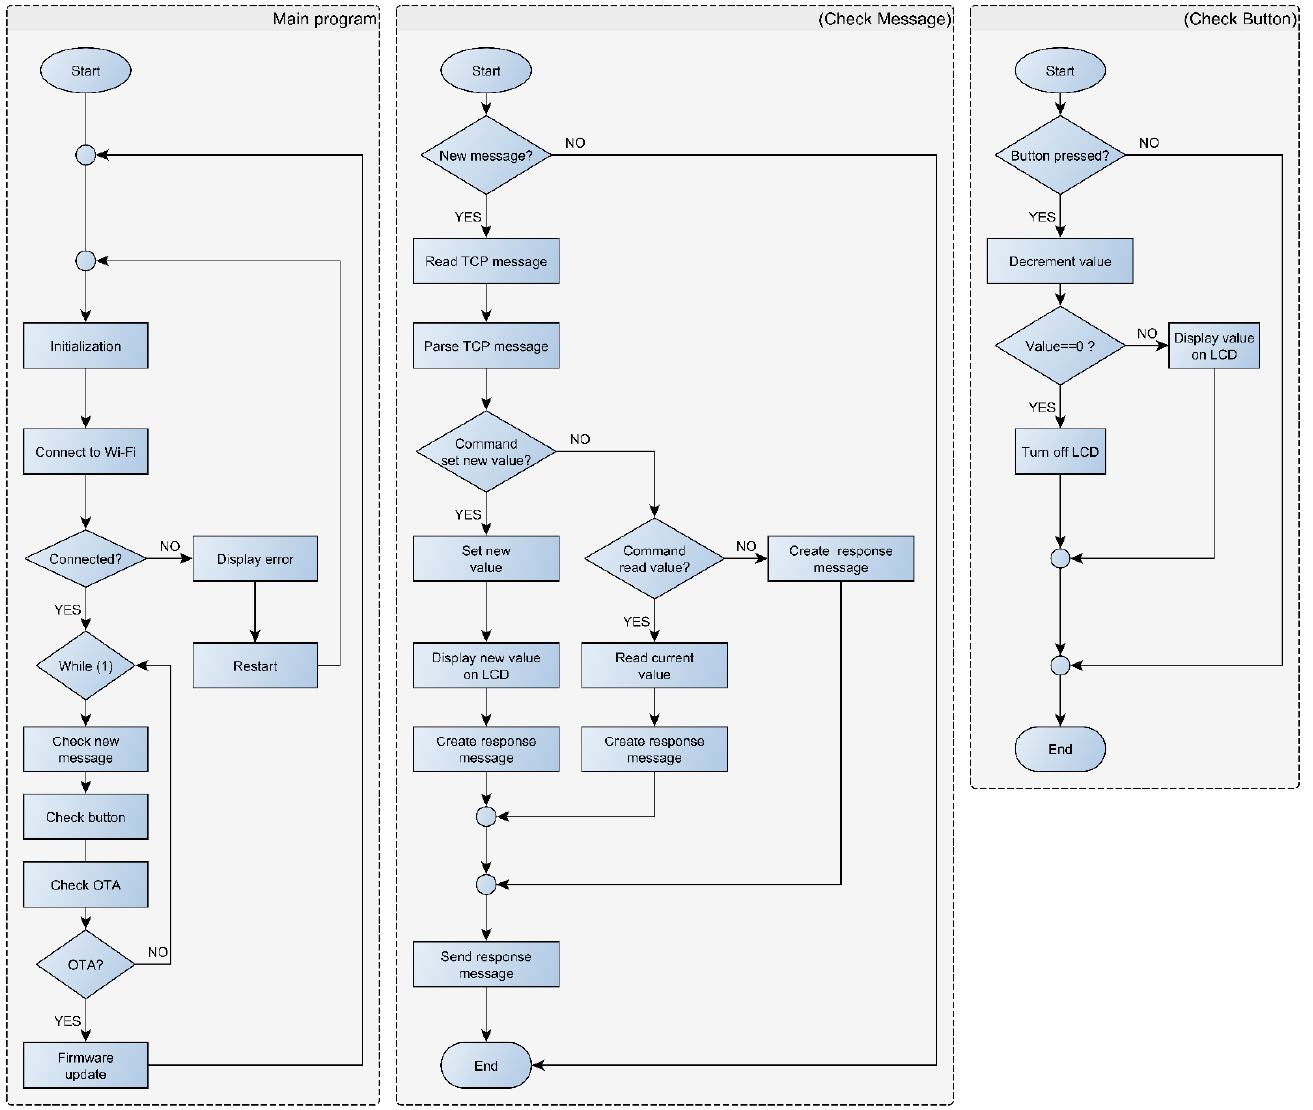
Figure 7. PTL module firmware flow chart.